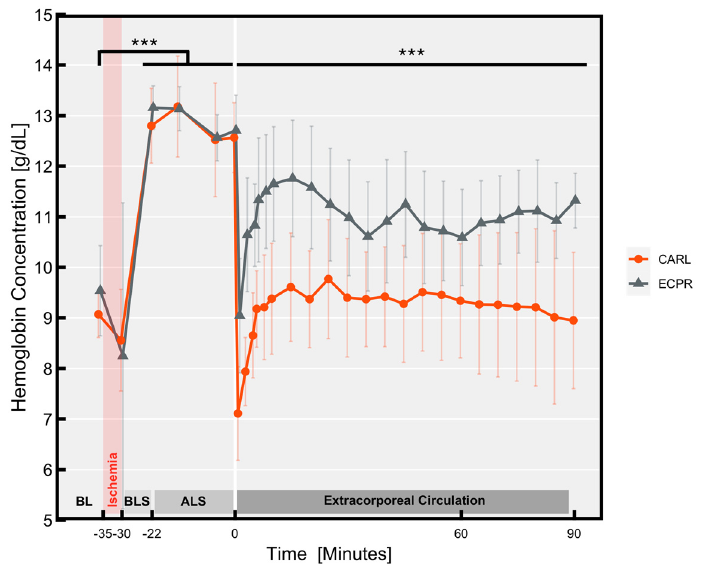
Figure 4. Haemoglobin concentration’s longitudinal course in arterial blood. Data are expressed as mean ± SD. BL Baseline, BLS Basic life support, ALS Advanced life support. (*** p < 0.001).